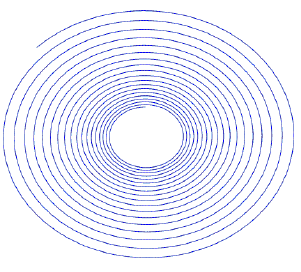
Figure 1. Scanning path of nanosecond laser processing. Table 1. Thermodynamic parameters of TC4.